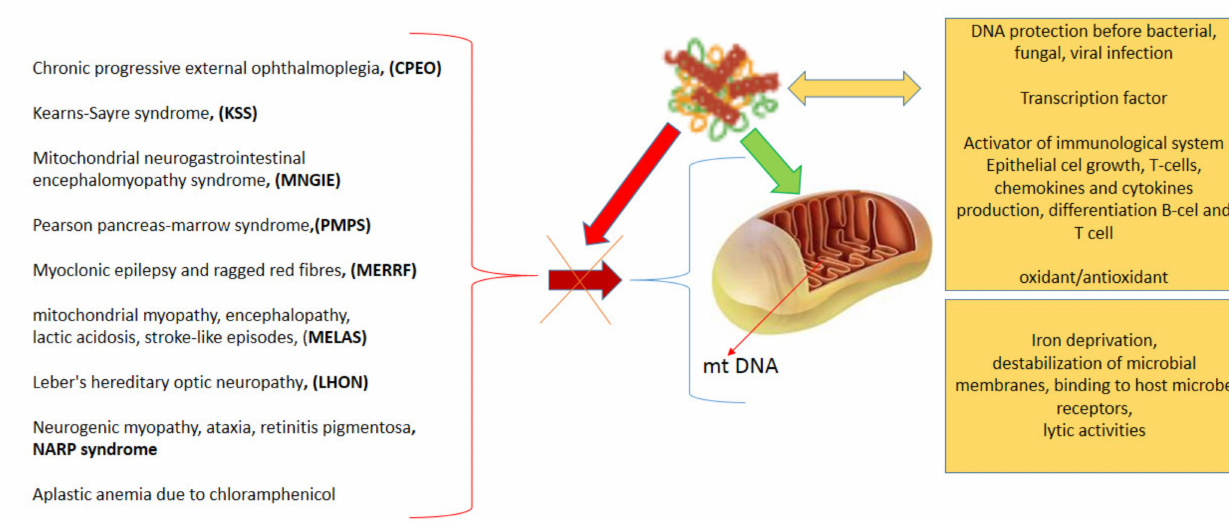
Figure 4. Protective role of LF against mitochondrial damage. Mitochondrial damage is a phe- nomenon that occurs in various diseases. LF can protect mitochondria by multiple mechanisms, acting as an antipathogenic agent and activating immune cell